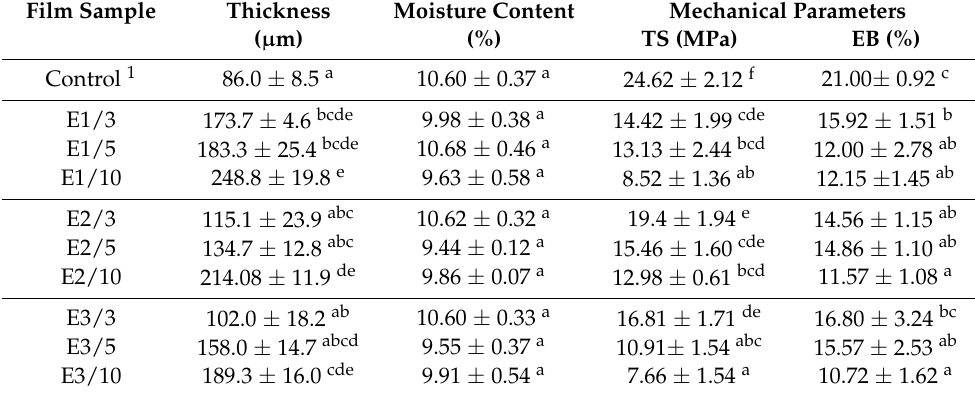
Table 2. Thickness, moisture content and mechanical parameters of films with propolis